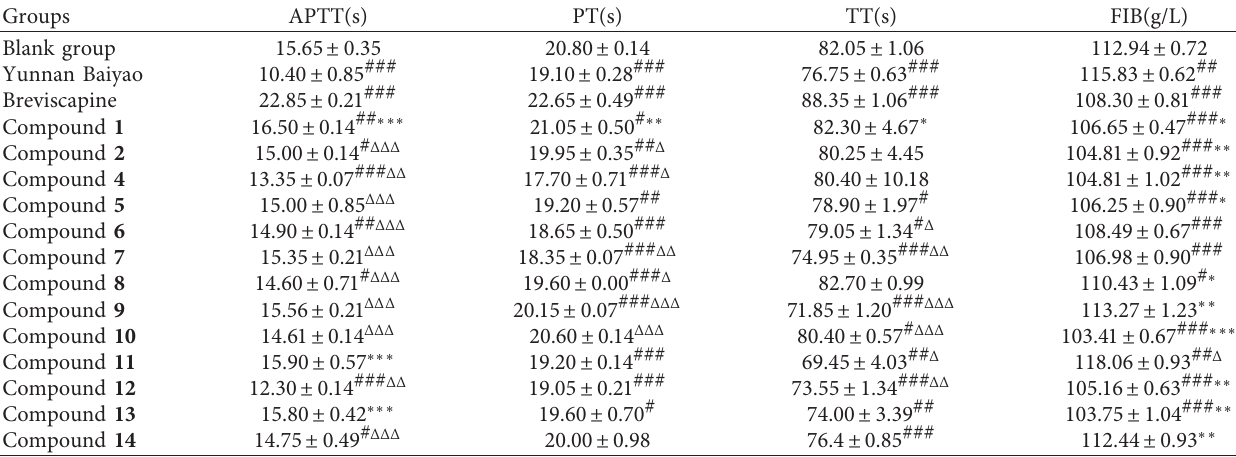
Table 1: Effects of compounds on plasma coagulation parameters in vitro .